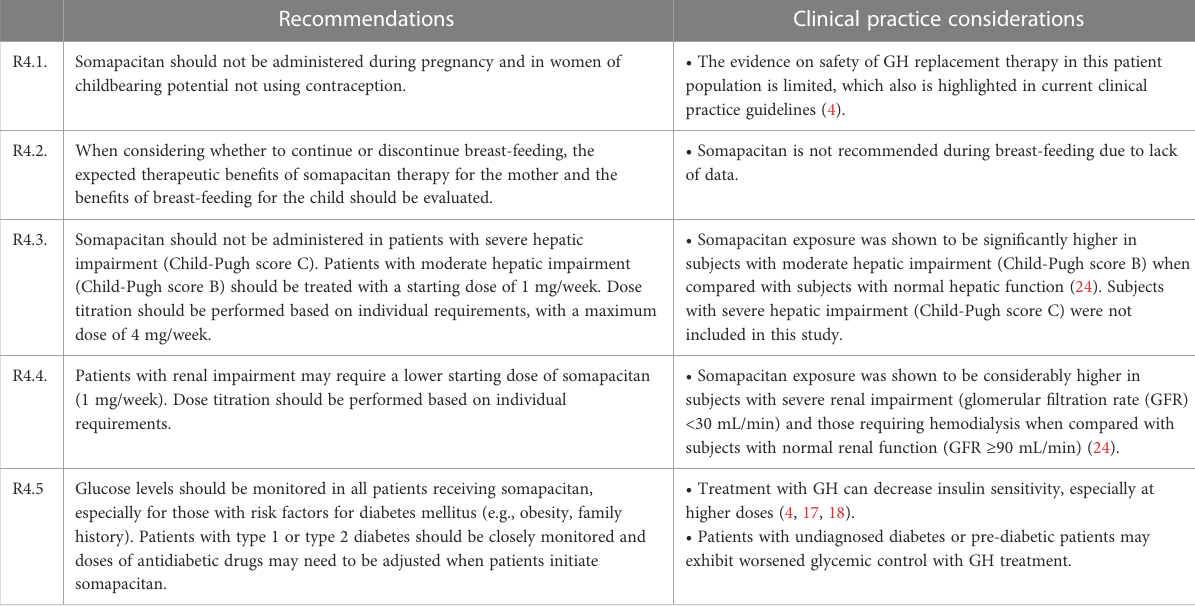
TABLE 4 Recommendations for special